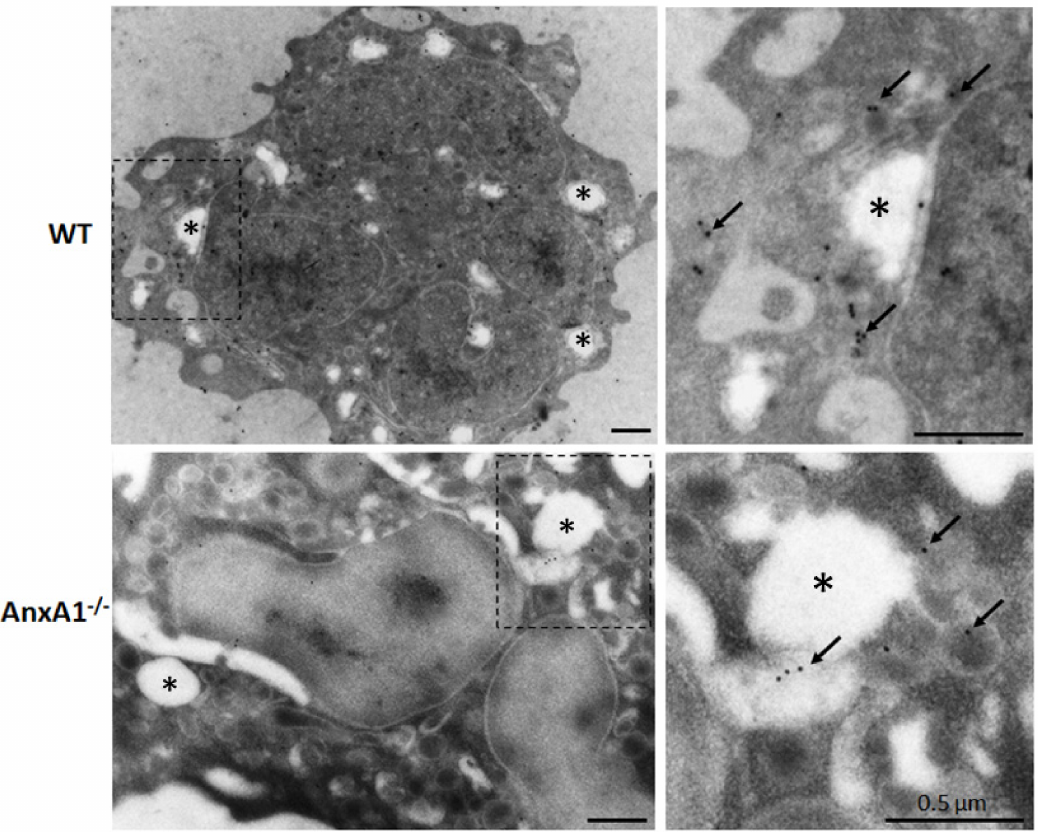
Figure 2. Expression of NLRP3 in WT and AnxA1 -/- nigericin-stimulated neutrophils. Immunogold labeling of NLRP3 (arrows) was detected in the cytoplasm of the neutrophils from both genotypes. These cells also contained cytoplasmic vacuoles (asterisks) that characterize their activation by nigericin. Images on the right side show details of the highlighted areas of the respective images on the left side. Representative images of three experiments